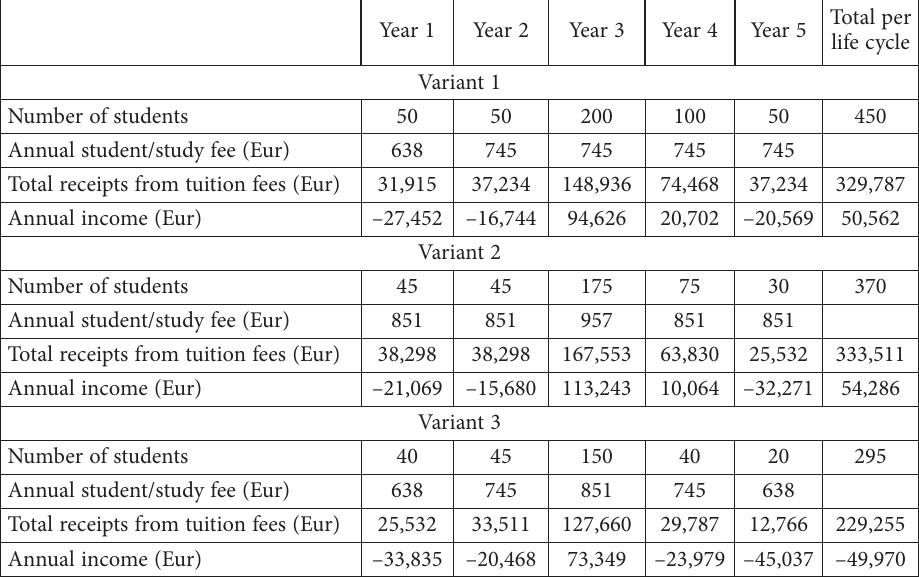
Table 13. Sensitivity analysis by the number of students and the amount of annual fee – multi-direc- tional analysis